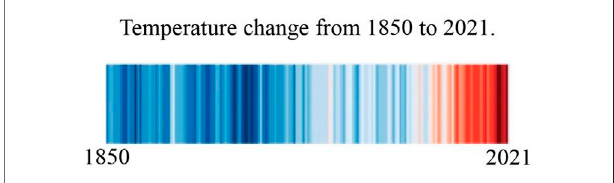
FIGURE 3 | Change in temperature of world climate from 1850 to